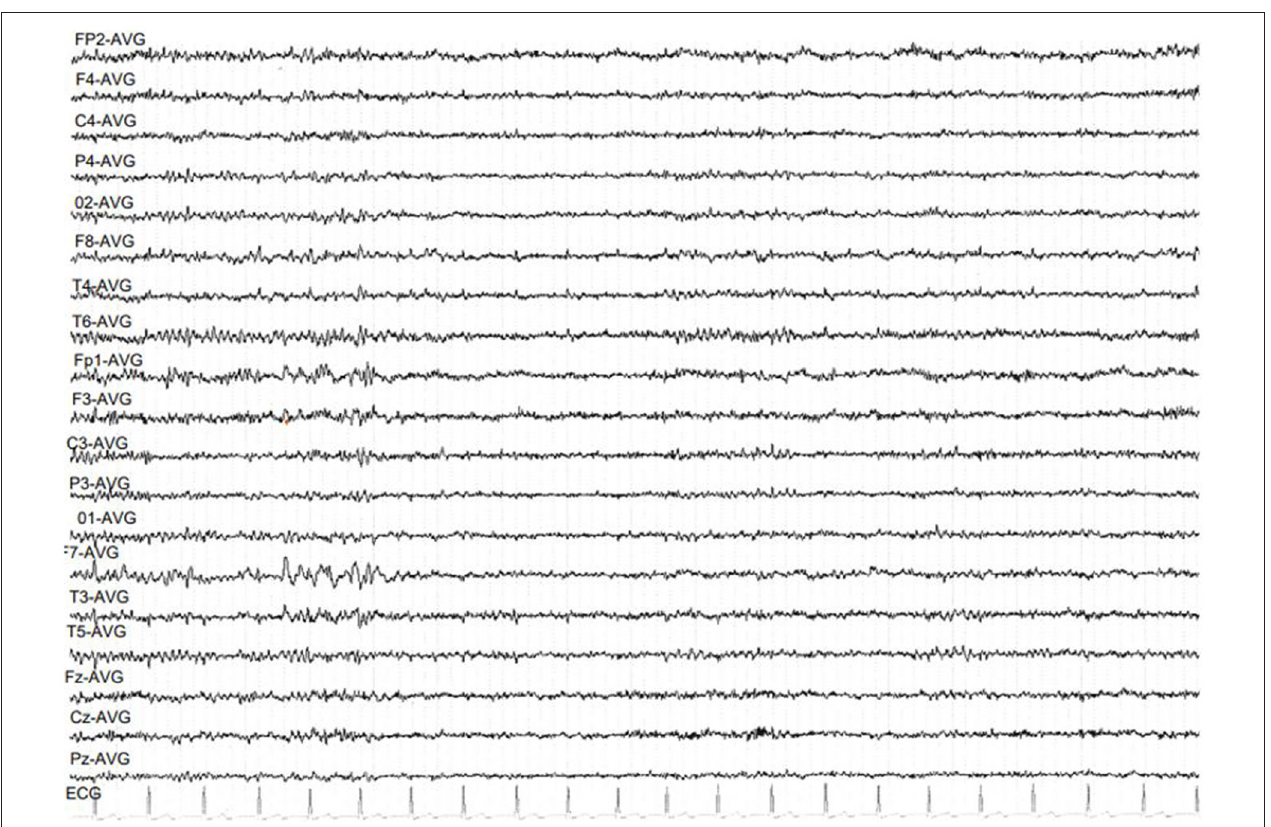
FIGURE 2 | EEG showing slow wave focus associated with spikes on the left temporal